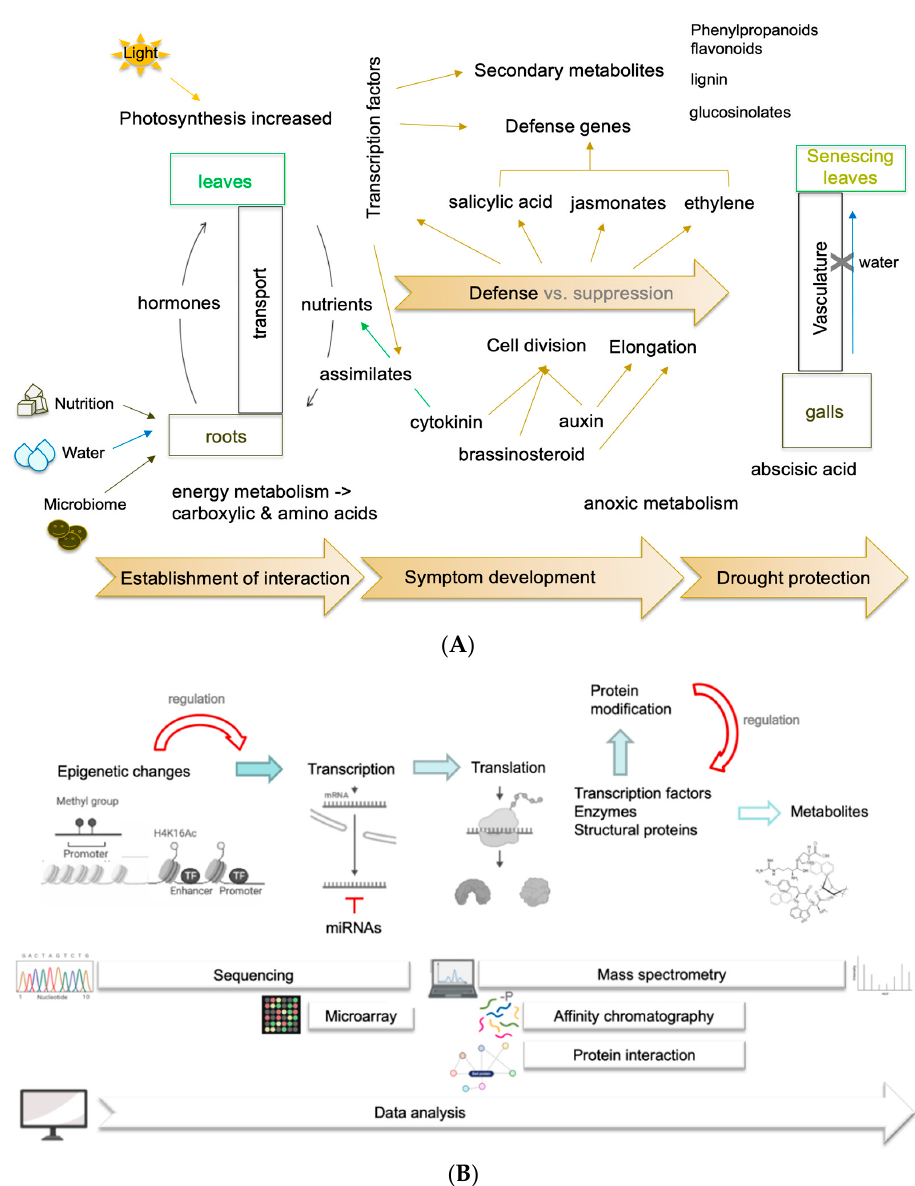
Figure 4. ( A ) . Model for molecular alterations in clubroots between the leaves and roots of host plants. These are generalized for different hosts ( A. thaliana , various Brassica species) and compiled for different approaches to -omics data. ( B ) . The regulatory processes, methods, and techniques are shown in the lower part of the figure. Some cartoons were taken from the free version of Biorender (last accessed 23 April 2022).